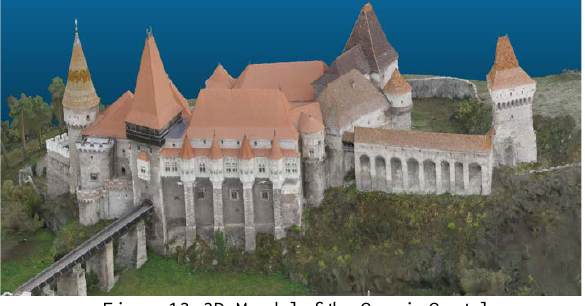
Figure 13. 3D Model of the Corvin